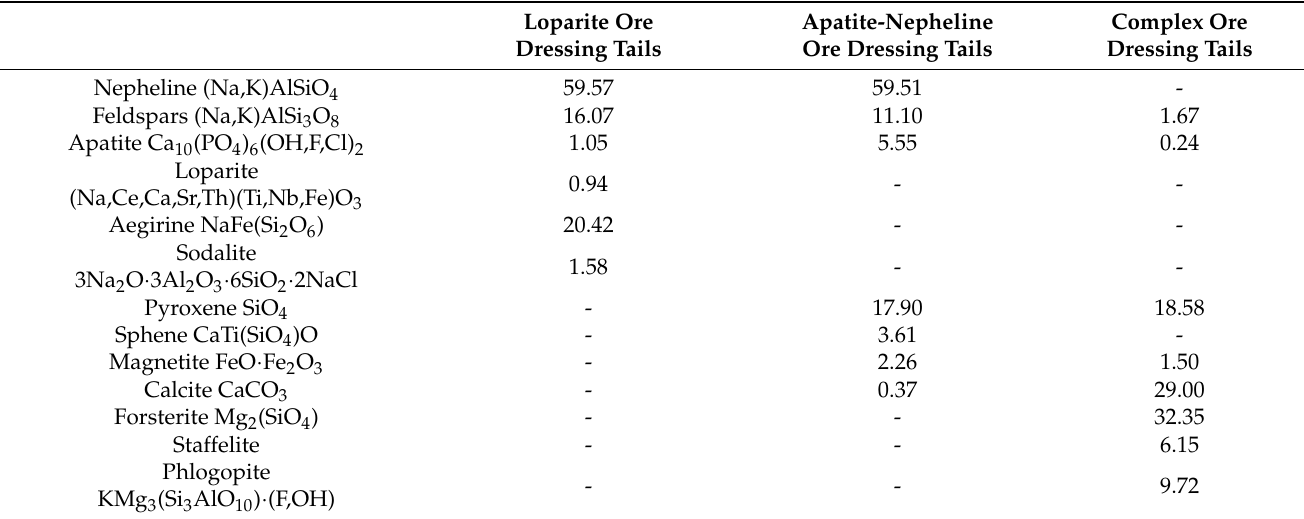
Table 4. The mineral composition of the ore dressing tails, %.